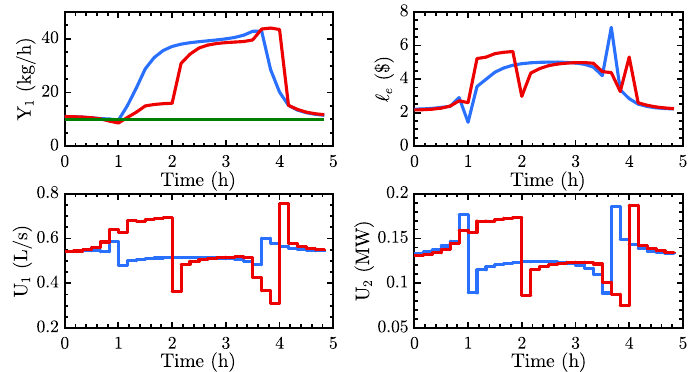
Figure 7. CO 2 emission, input and economic cost trajectories of the PCC plant for scenario 1 with carbon tax set at $50.00 per tonne CO 2 . EMPC (blue), MPC (red), Emission limit (green); ( top-left ) mass flow rate of CO 2 in the treated flue gas; ( top-right ) economic performance of controller; ( bottom-left ) volumetric flow rate of solvent; ( bottom-right ) heat input to